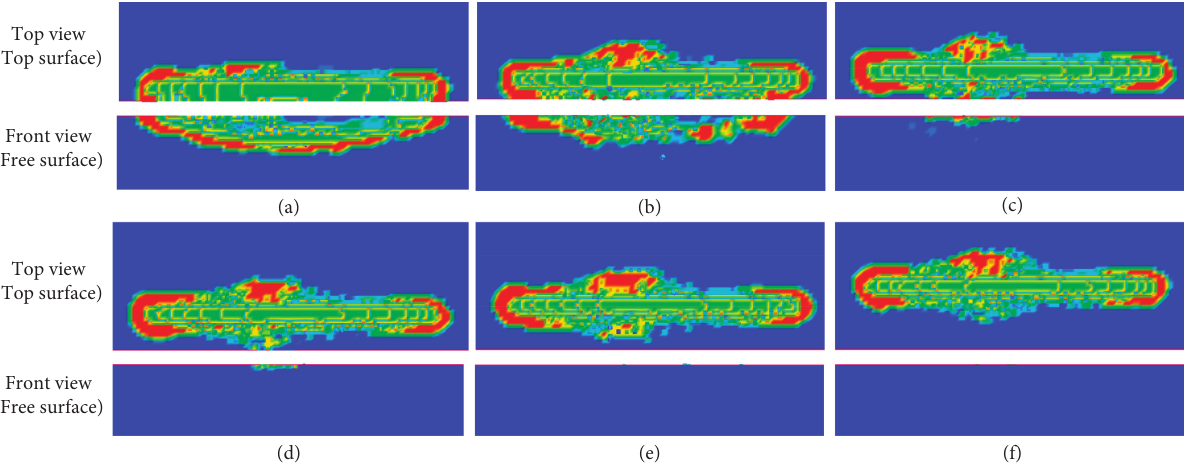
Figure 7: Damage nephogram of sawblade cutting vertically into rock at different distances from free surface of